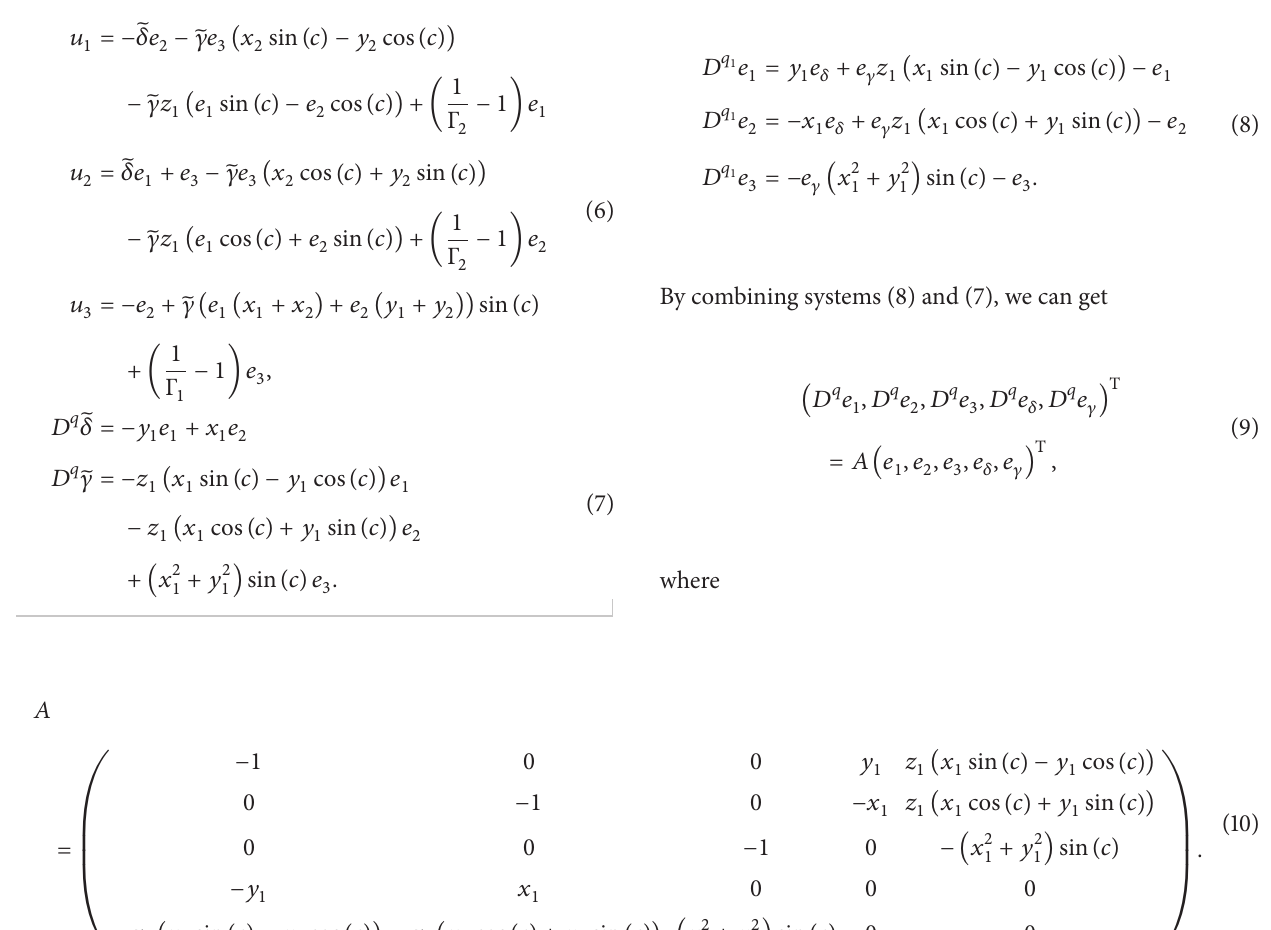
Theorem 2. Adaptive synchronization between systems (3) and (4) is realized when the controllers and laws of